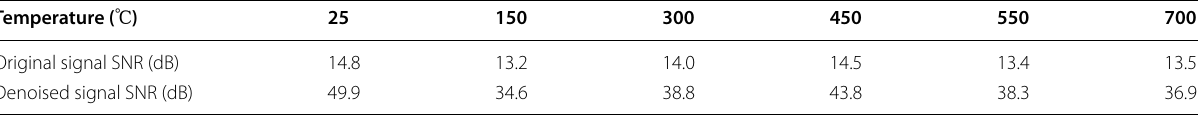
Table 2 Comparison of the noise reduction performance of Cr25Mo3Ti at different temperatures for low voltage detection Temperature ( ℃ ) Original signal SNR (dB) Denoised signal SNR